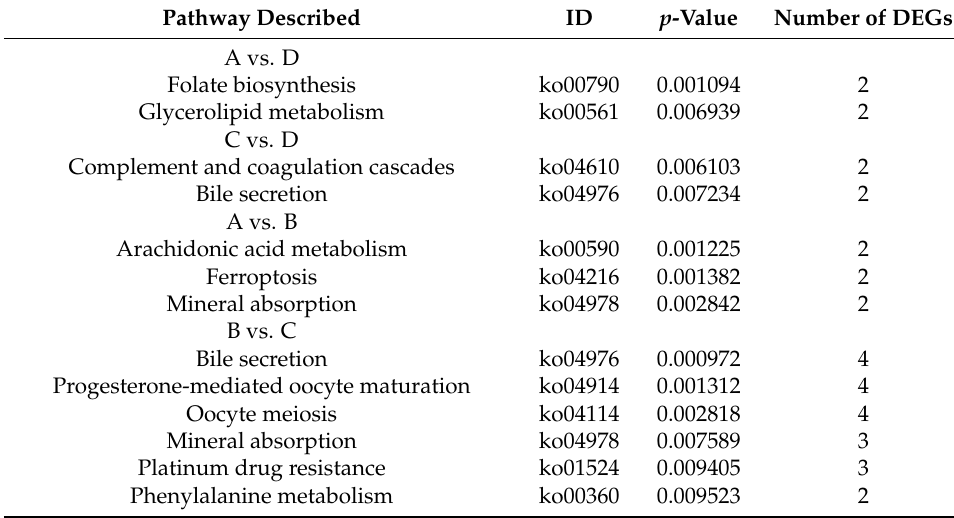
Table 3. Kyoto Encyclopedia of Genes and Genomes pathways of differentially expressed genes between bats in different comparative